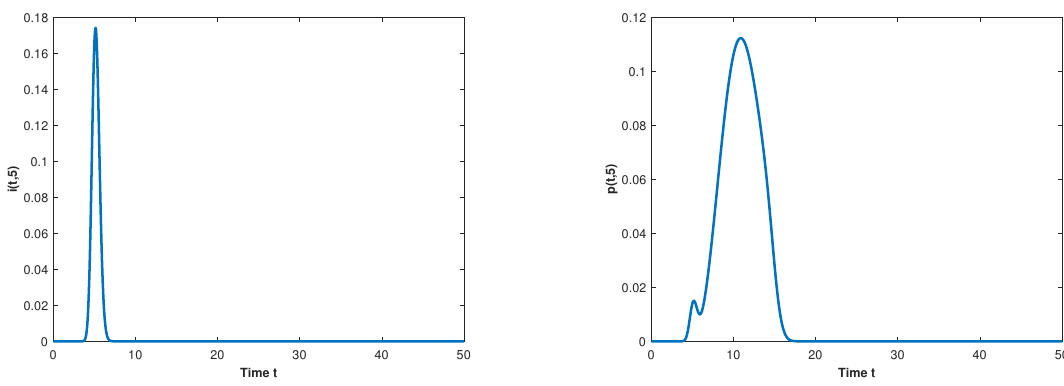
Figure 2. The long-term dynamical behavior of i ( t , a ) and p ( t , b ) for a = b = 5 as q = 10 − 10